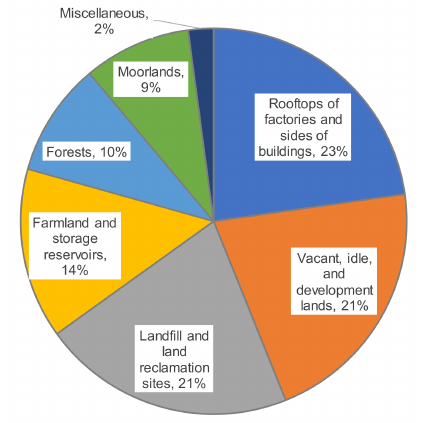
Figure 3. PV solar plants installed on steep hillsides. Photography by author.